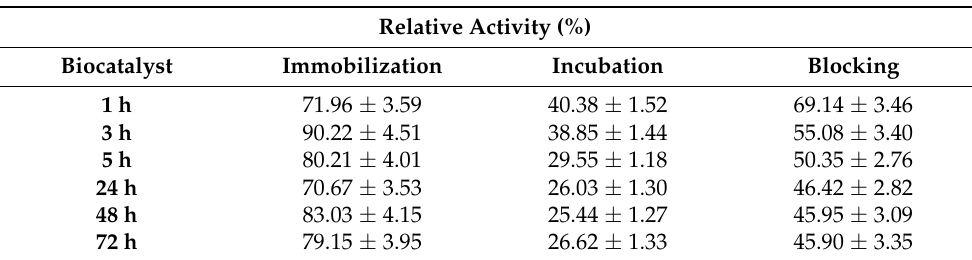
Table 3. Effect of the incubation time on the expressed activity of PGA immobilized on VS-agarose The immobilization was at pH 7 and the incubation was performed in sodium carbonate 50 mM (containing 100 mM phenyl acetic acid and 30% glycerol) at pH 10.0. Blocking was performed by incubation in 2 M glycine at pH 8.0. The experiments were conducted as described in the Methods.